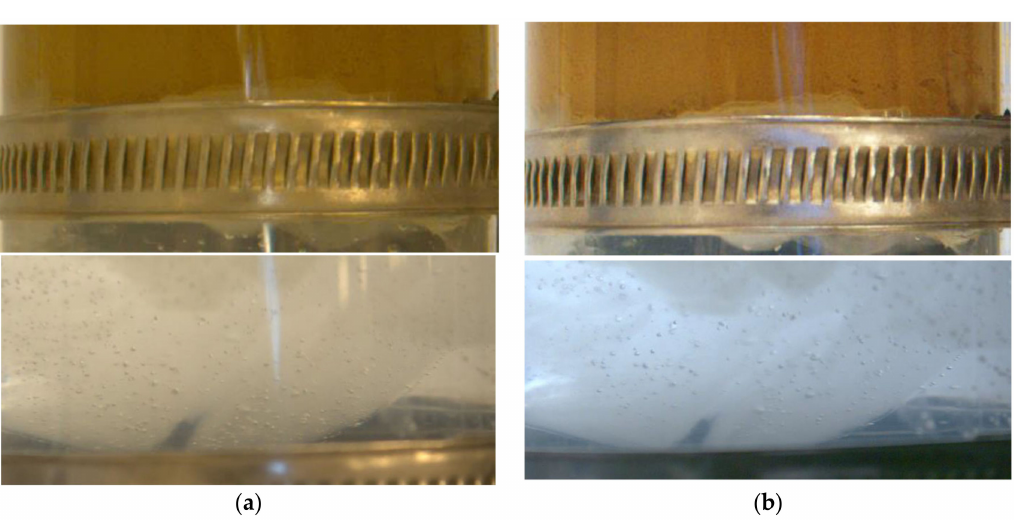
Figure 14. Picture of the laponite gel pill and model drilling fluid interface (upper picture), and brine and gel pill interface (bottom) at the 40 ◦ deviation tests, ( a ) initially and ( b ) after 24